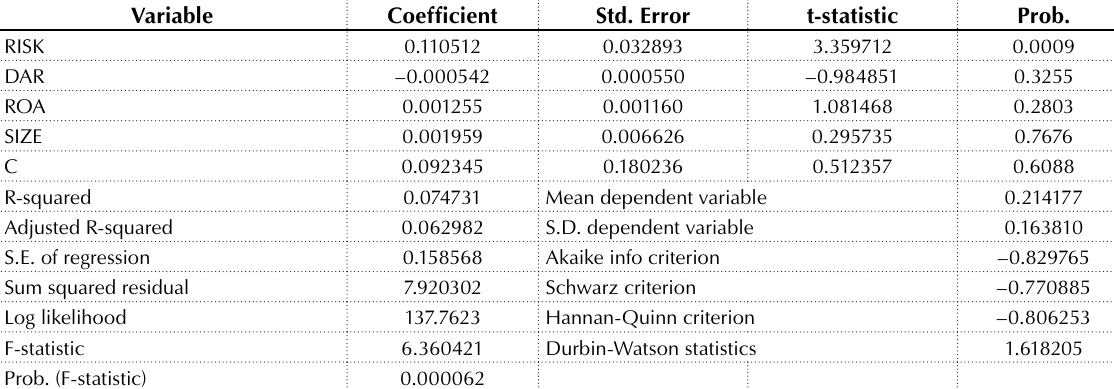
Table 3. Heteroscedasticity